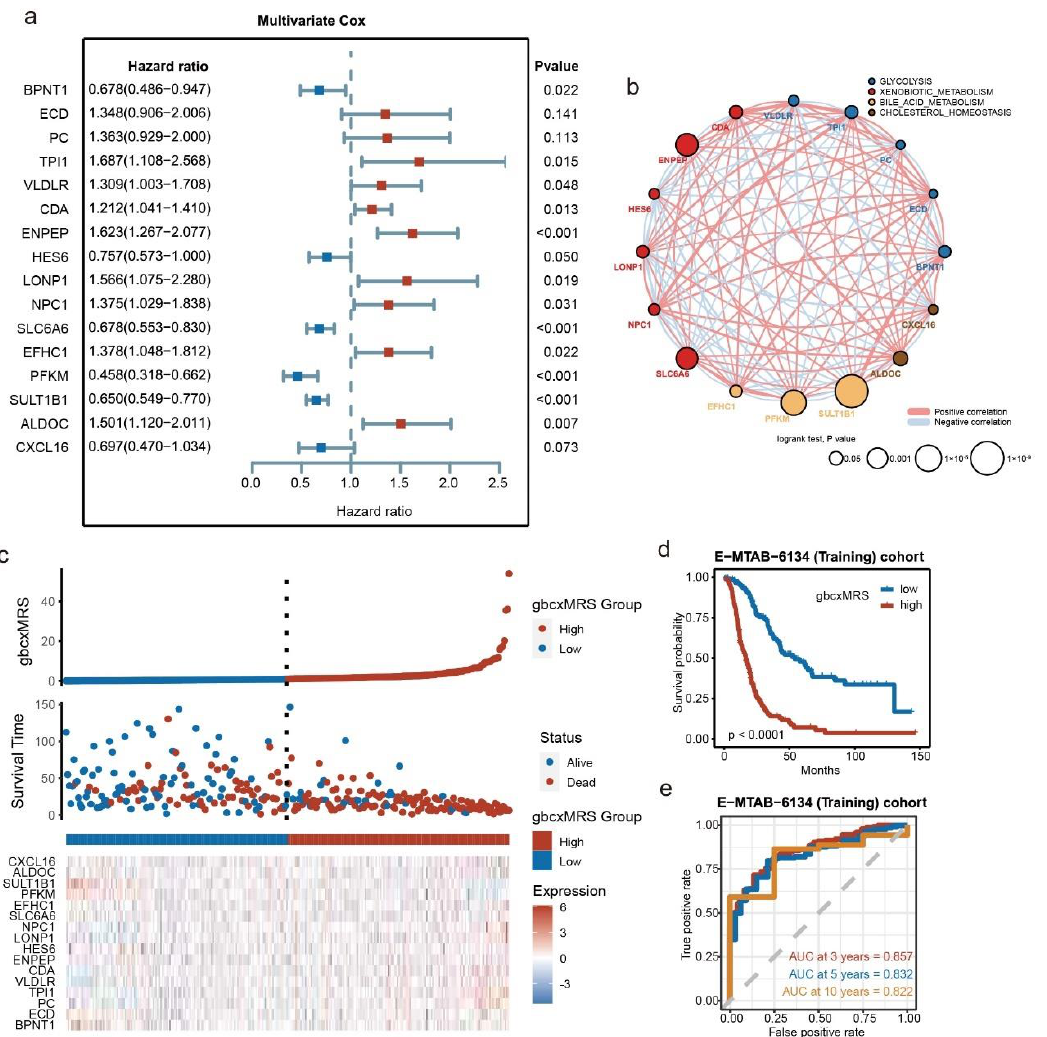
Figure 3. Development of the signature from key metabolic pathways in the E-MTAB-6134 cohort. ( a ) Multivariate Cox regression and stepwise regression finally screened 16 metabolism-related genes and their hazard ratios. ( b ) The network exhibited the pathways to which each gene belongs, the significance of each gene in the model and the correlation between 16 genes. ( c ) The landscape of gbcxMRS, survival status and gene expression. ( d ) Kaplan–Meier survival analysis between the high ( n = 144) and low ( n = 144) gbcxMRS groups. ( e ) AUC of 3-, 5- and 10-year time-dependent ROC